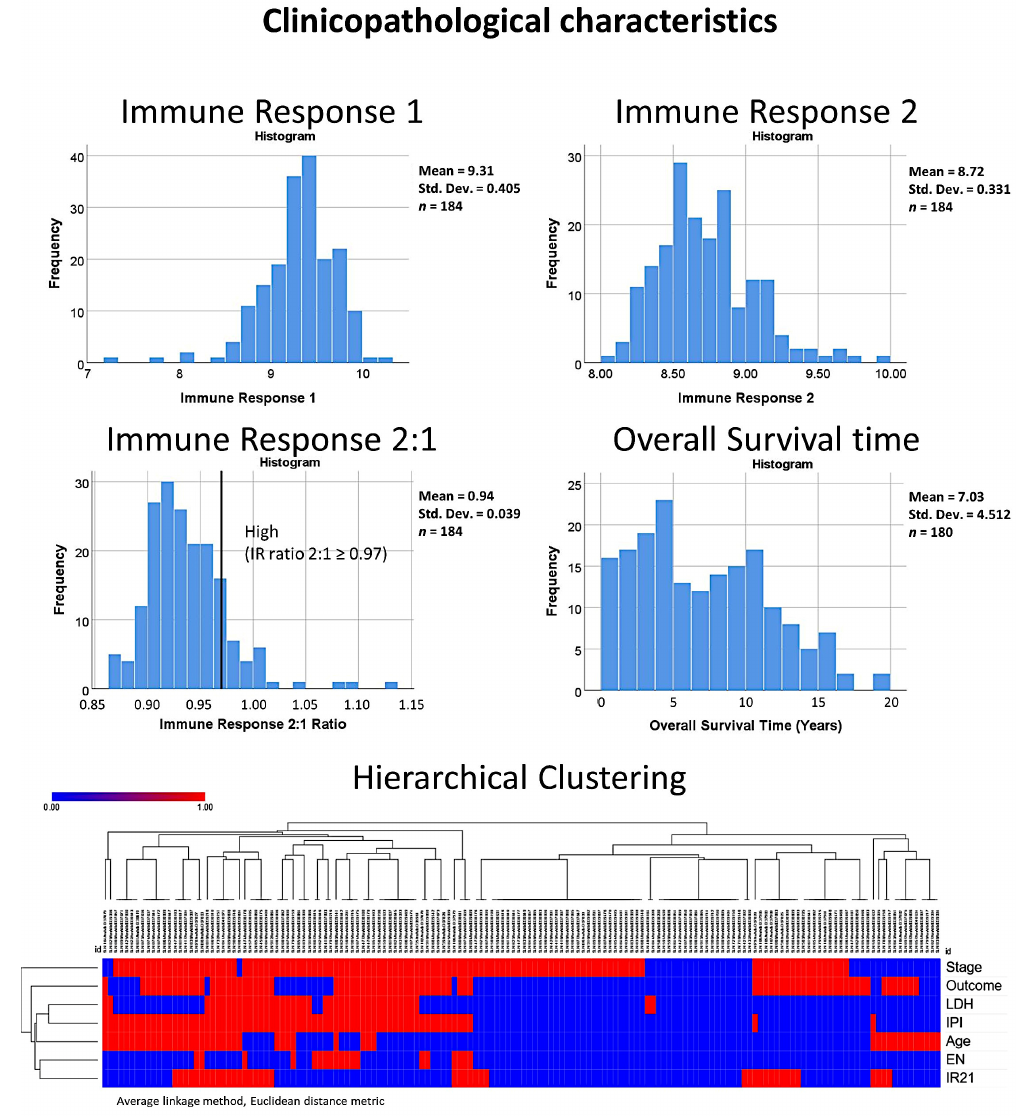
Figure 2. Clinicopathological characteristics of the series. The histograms show the distribution of the data for the immune response variables (1, 2 and the 2:1 ratio). The immune response variables are based on the gene expression of markers that are characteristic of the tumoral immune microenvironment and host immune response (T cells, macrophages, etc.), as originally described by Dave SS et al. and published in N Engl J Med 2004 [12]. In this project, we created an immune response 2:1 ratio and the cut-off value of 0.97 was use in the overall survival analysis. The overall survival time of the series is also shown. The distribution and correlation of the different variables is also shown in the hierarchical clustering with dendrogram and heatmap.